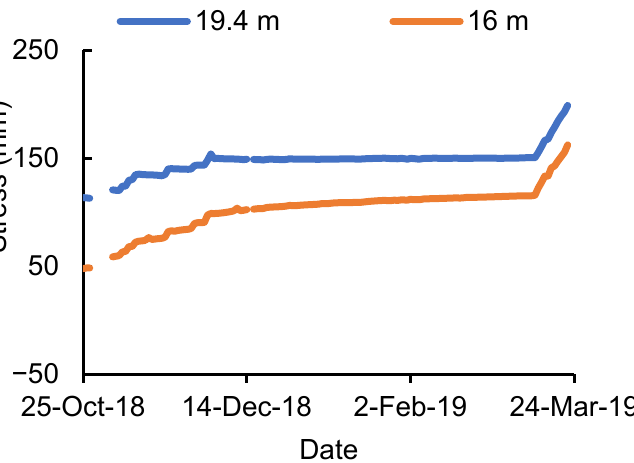
Figure 11. Horizontal stresses (the blue line is at 19.4 m, and the orange line is at 16 m).